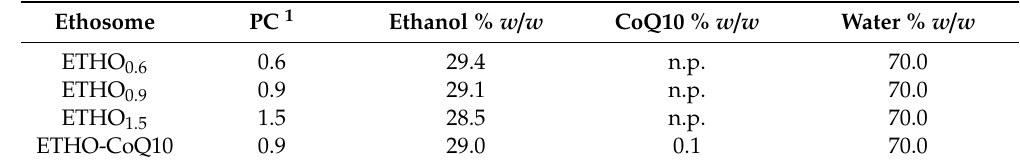
Table 1. Composition of ethosomes